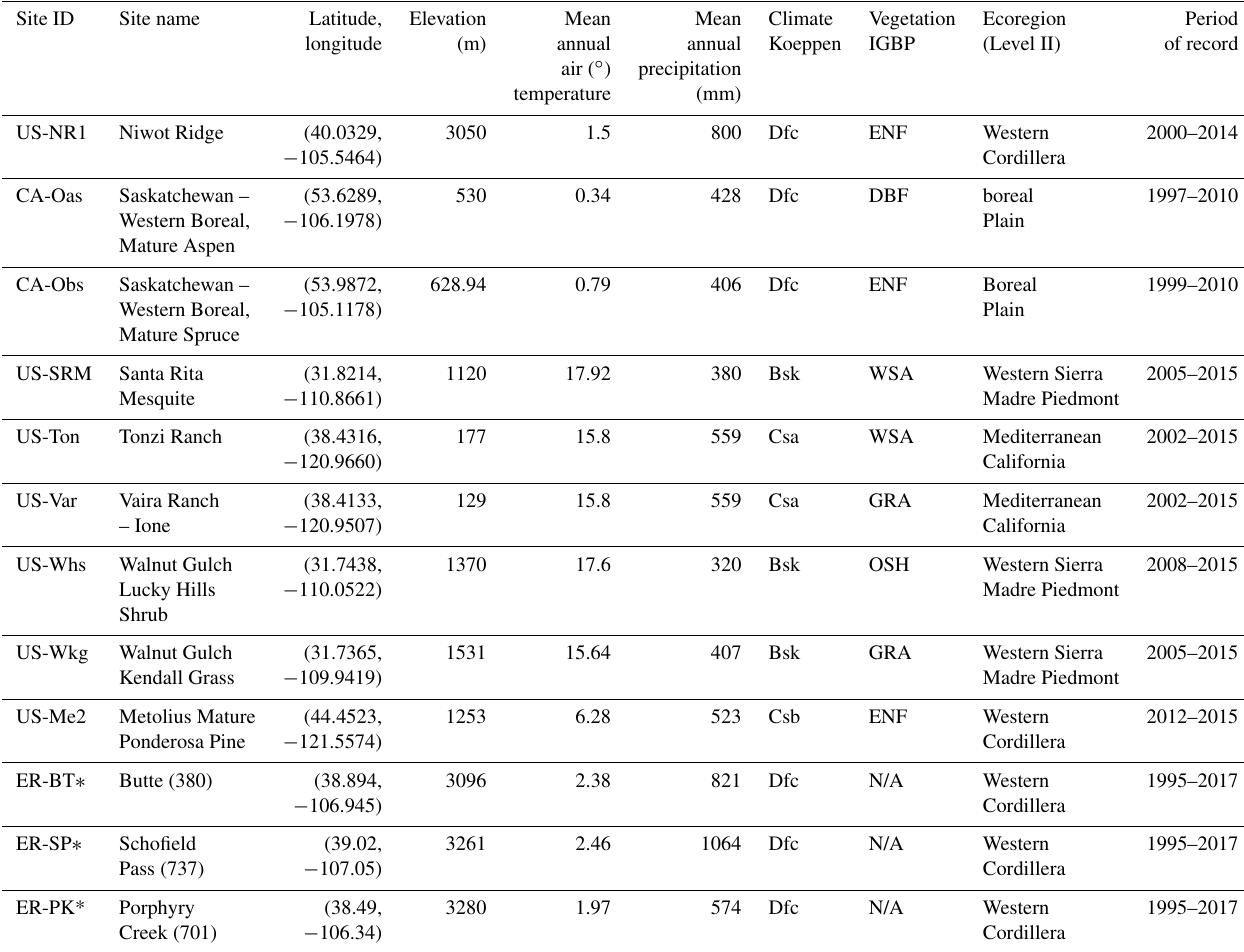
Table 1. Summary of FLUXNET stations and SNOTEL stations information. * denotes SNOTEL stations and all others are FLUXNET stations. Dfc, Bsk, and Csa represent subarctic or boreal climates, semi-arid climate, and Mediterranean hot summer climates, respectively. ENF, DBF, WSA, GRA, and OSH represent evergreen needleleaf forest, deciduous broadleaf forests, woody savannas, grasslands, and open shrubland, respectively. FLUXNET data were obtained from the FLUXNET2015